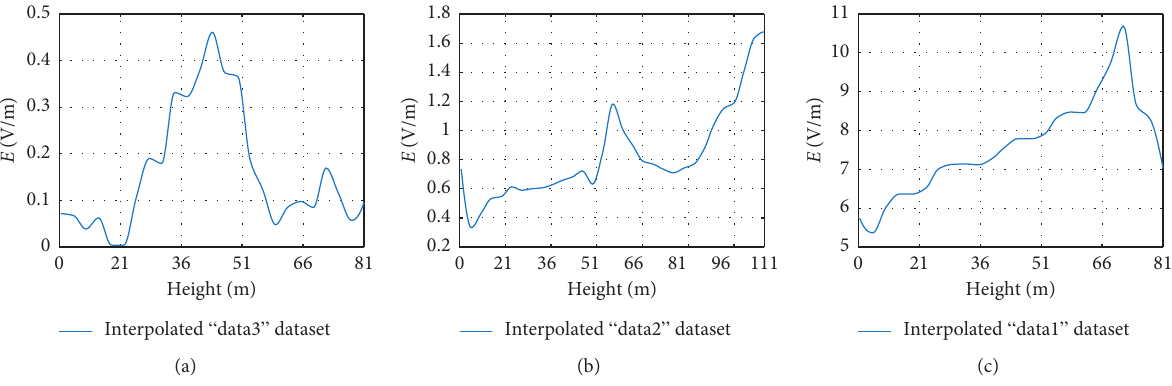
Figure 3: Graph for interpolated (a) “data3” dataset; (b) “data2” dataset; (c) “data1” dataset.